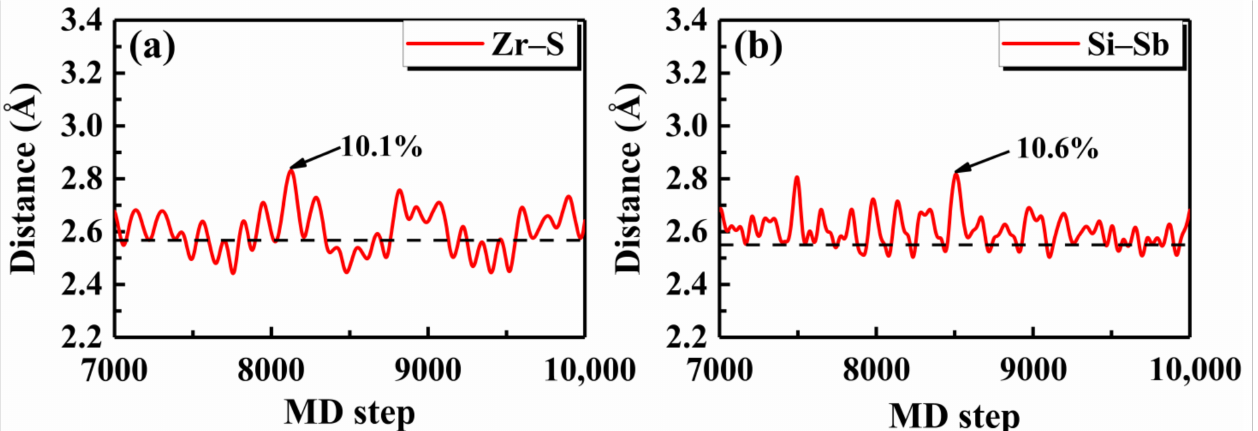
Figure 5. The AIMD results of the bond distances for the Janus monolayers ( a ) ZrSTe at 300 K, and ( b ) Si 2 PSb at 350 K, where the equilibrium lengths are indicated by the dashed lines and the maximum bond length fluctuations are